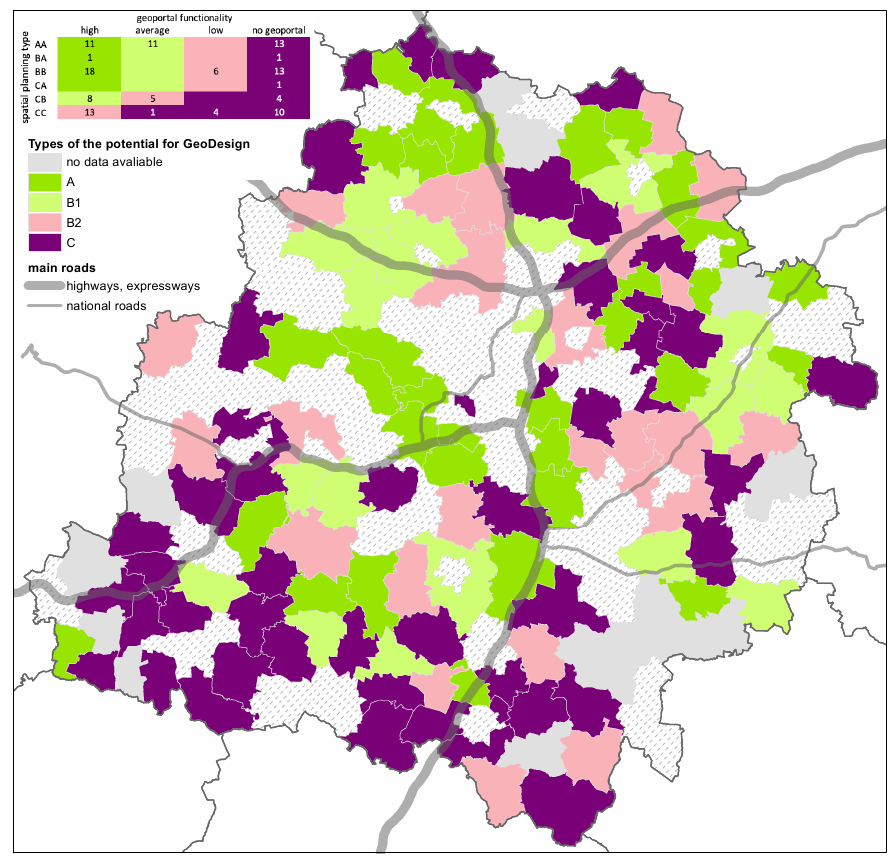
Figure 8. The spatial patterns for the potential of the GeoDesign concept to be implemented in Łód´z voivodeship’s rural gminas in